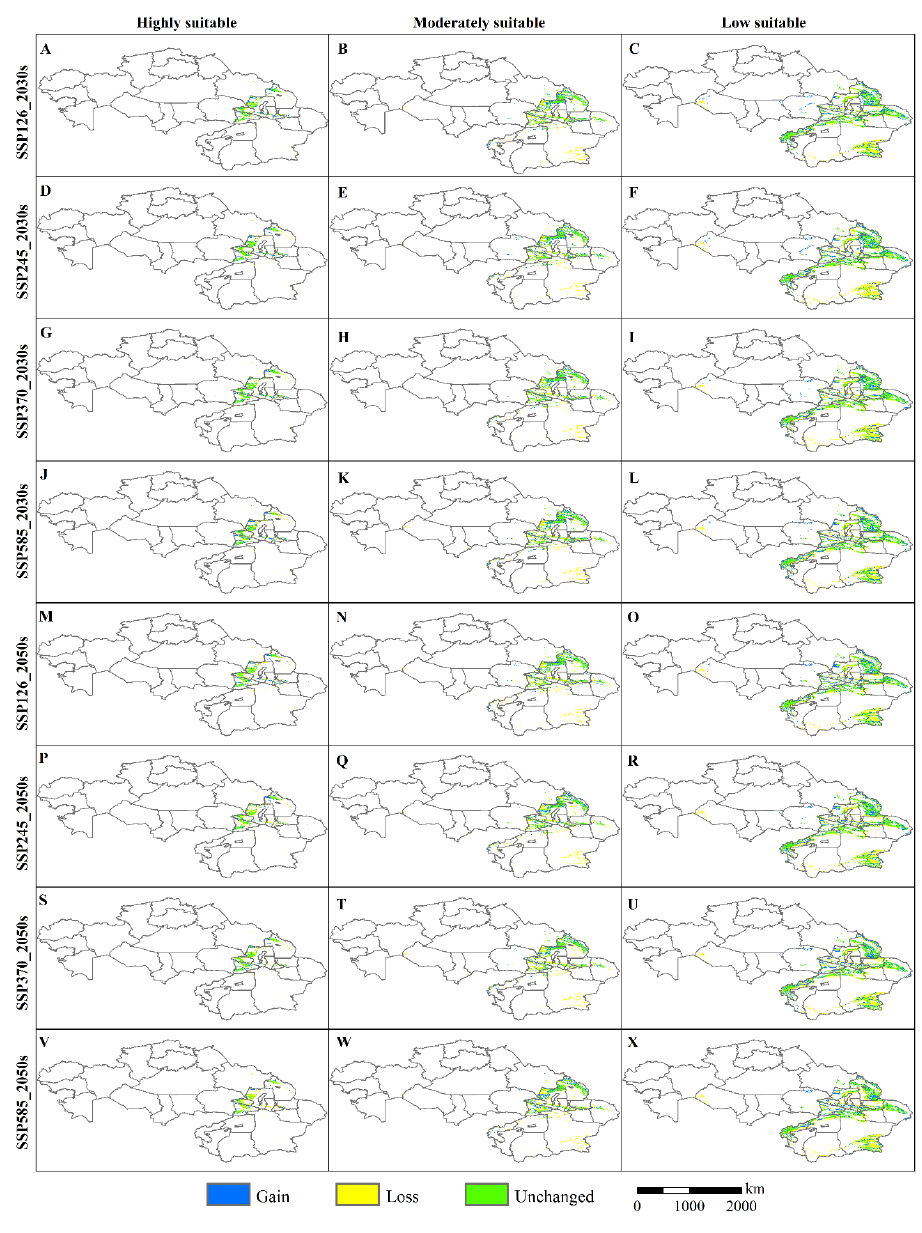
Figure 6. ( A – X ) Changes in potential habitats of typical locust species relative to current habitats based on different climate scenarios in the 2030s and 2050s.